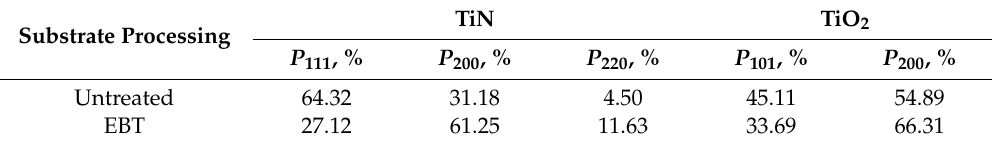
Table 1. The shares of microvolumes of different texture components evaluated by P hkl .